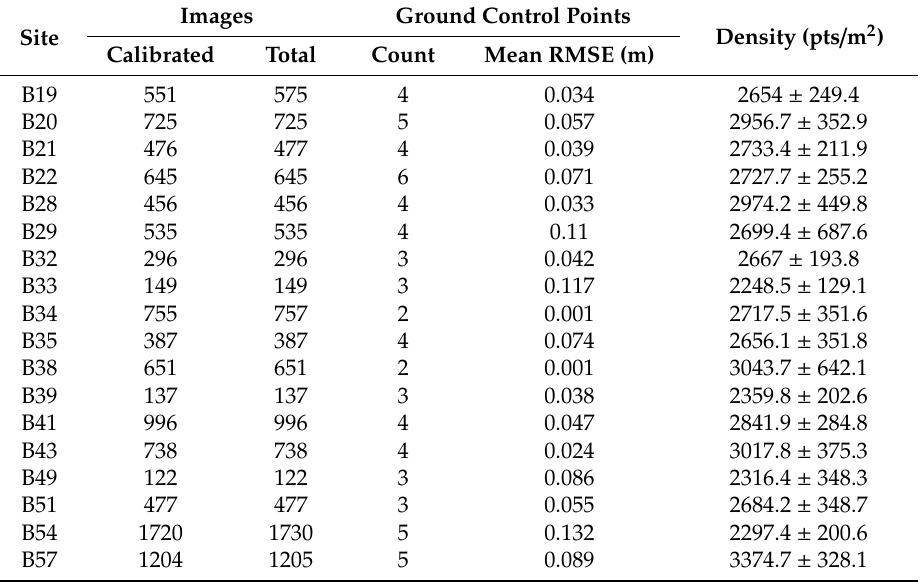
Table 2. Input UAV imagery, ground control point counts with mean root mean square error (RMSE), and output point density (mean and standard deviation) for each of the eighteen stands. Mean point density was calculated by sampling ten 50 m 2 plots, which were evenly distributed throughout each